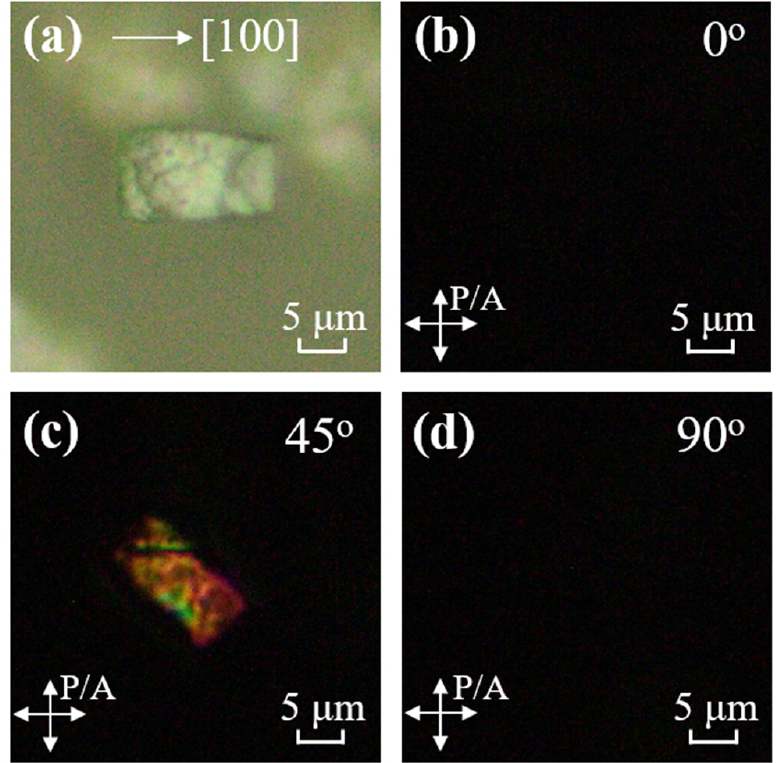
Figure 5. ( a ) The photograph of BaTiO 3 plates. The PLM images of BaTiO 3 micron plates with the crossed polarizers at ( b ) 0 ◦ , ( c ) 45 ◦ , and ( d ) 90 ◦ . To further investigate the local domain structure in the micro-scale BaTiO 3 plates, PFM was performed on an individual plate. It can be seen that the out-of-plane as well as the in- plane amplitude images exhibit distinct contrast of about 180 ◦ , which is also revealed in the corresponding phase images. Figure 6a shows an out-of-plane PFM image recorded on the (001) surface of the plate, whereas the normal edge of the plate is oriented parallel to <001>- axis or <010>-axis. Figure 6c–f are the enlarged view of the region marked in Figure 6a. The roughness of this enlarged region extracted from the surface morphology image is ~43.5 nm. The rough surface is consistent with the FE-SEM results observed in Figures 1 and 4, which may be caused by the variation in growth rate in the different regions of the plate. Out-of-plane and in-plane images in the region of 6 µ m × 6 µ m area were recorded. The bright and dark stripes show the in-plane polarization with opposite directions along the <100>-axis (or <010>-axis), respectively. In the out-of-plane images, the bright and dark stripes indicate polarization with opposite directions along the <001>-axis. The BaTiO 3 plate shows a group of regular 90 ◦ ferroelectric banded domains with an average domain width of ~125 nm. In Figure 6b, a 3D schematic domain structure is sketched according to the possible orientation of the domains in the T phase (001) plate. Arrows indicate the orientation of spontaneous polarization ( P s ). In the a 1 /a 2 -domain, the P s is parallel with the surface of the plate, marked as P 1 . In the c -domain, the P s is perpendicular to the